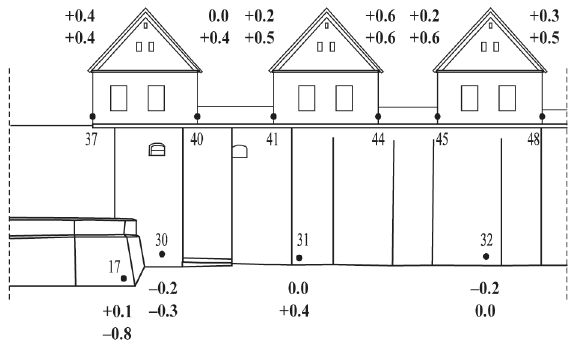
Fig. 8. Benchmarks on the hermitages